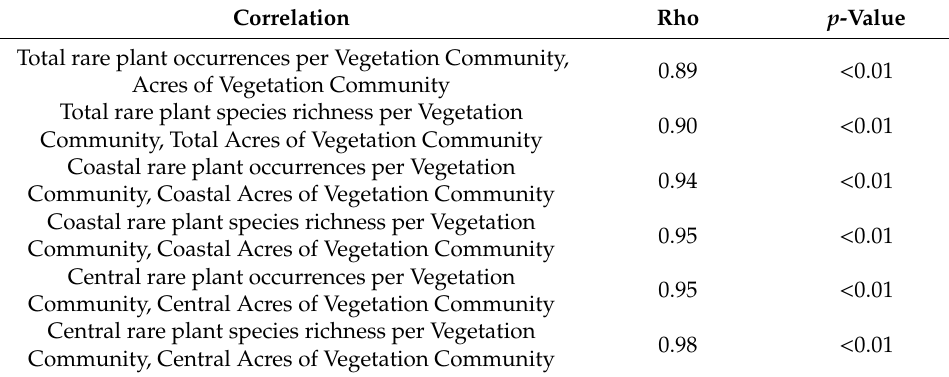
Table 3. Spearman rank correlation analysis of the acreage of vegetation community by the occurrences of rare plants within each vegetation community and the rare plant species richness within each vegetation community. All analyses were significantly positively correlated. This indicates that occurrences and richness increase with the increasing size of each vegetation community.